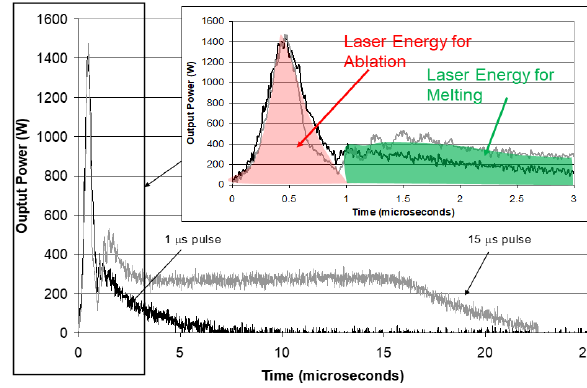
Figure 2: Profiles of 1- µ s and 15- µ s laser pulses. Both pulses have an identical initial spike at 1,450 W which is approximately five times of the steady state power of 300 W. This is an improved diagram from Tu et al. (2016).